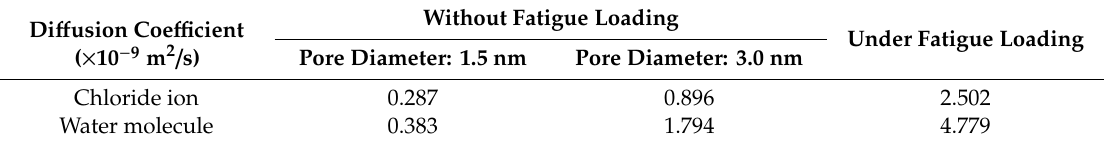
Table 2. Di ff usion coe ffi cient of water molecules and chloride ions under di ff erent working conditions Without Fatigue Loading Di ff usion Coe ffi cient Under Fatigue Loading ( × 10 − 9 m 2 / s) Pore Diameter: 1.5 nm Pore Diameter: 3.0 nm Chloride ion 0.287 0.896 Water molecule 0.383